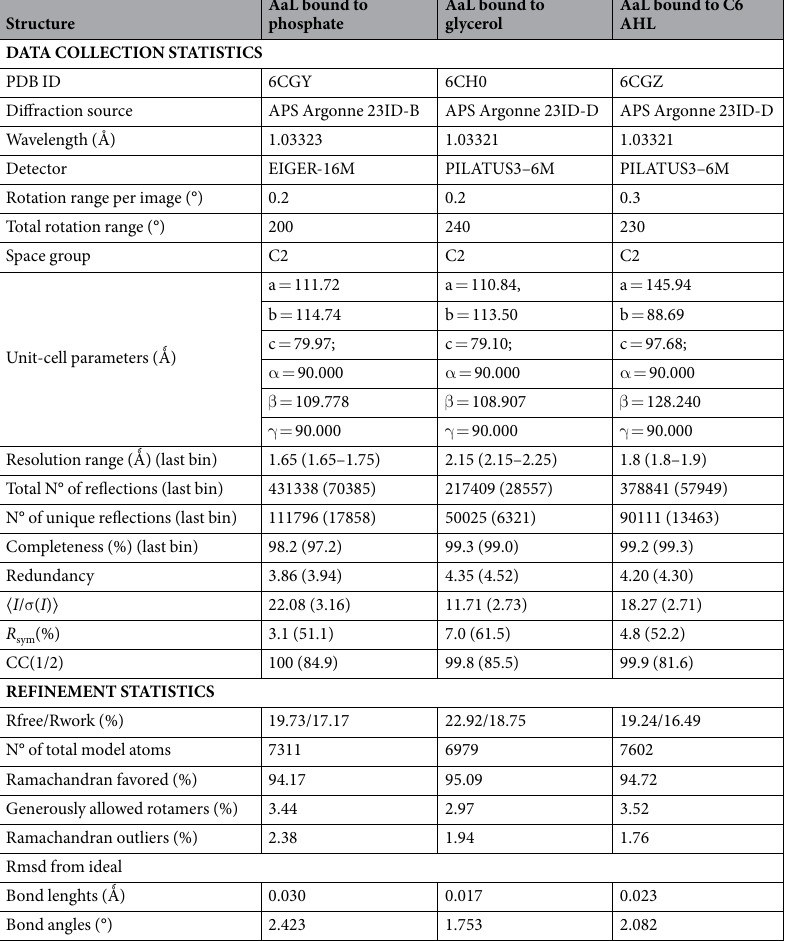
Table 3. Data collection and refinement statistics of AaL